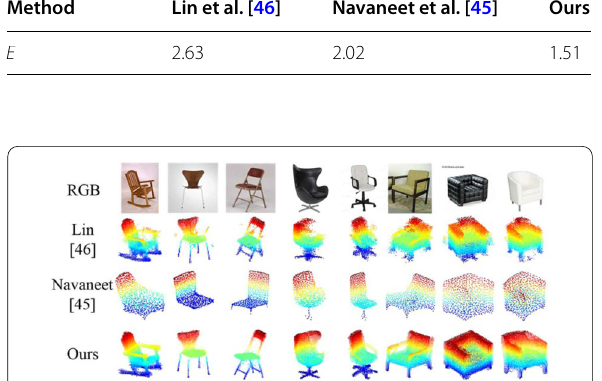
Figure 14 Qualitative comparison on the Stanford Online Products